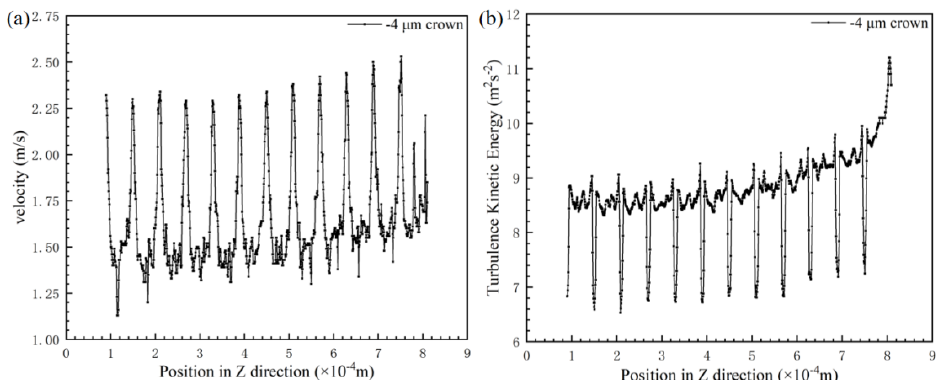
Figure 11. The wall sheer stress of negative crown microstructure at 12 m/s, and the vortex in neg- ative crown.